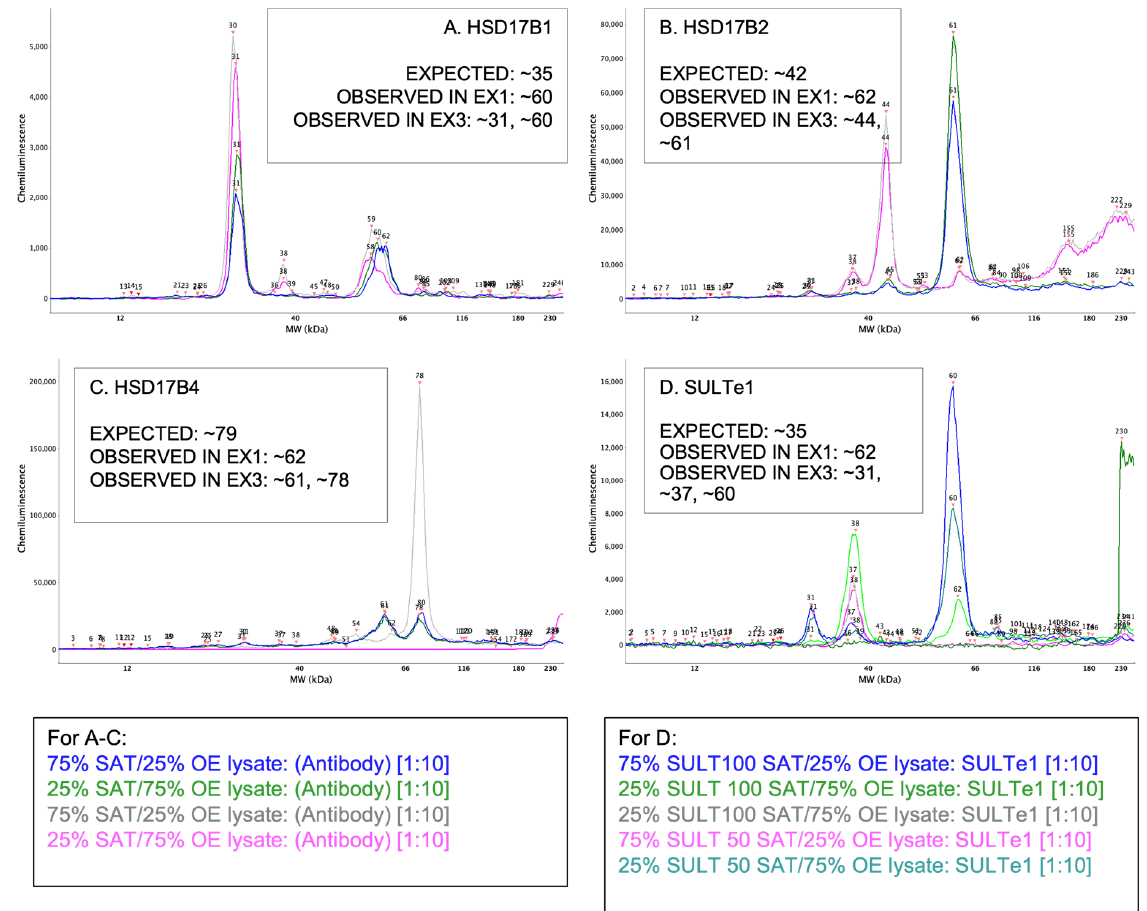
Figure 7. All electropherograms report data for high fat (75 SAT lysate:25 over-expresser lysate) and low fat (25 SAT lysate:75 over-expresser lysate) mixtures with 1:10 antibody concentrations in duplicate: ( A ) HSD17ß1 ( B ) HSD17ß2 ( C ) HSD17ß4 and ( D )